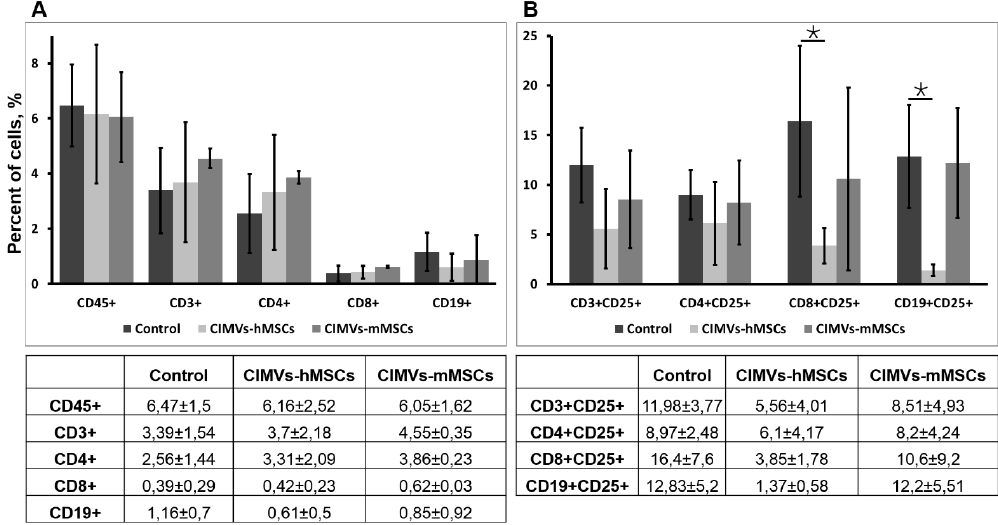
Figure 7. Immune response after CIMVs-hMSCs or CIMVs-mMSCs i.v. injection. Percent of the main populations of immune cells ( A ) and their activation status ( B ) were defined. Blood samples were collected 24 h after the i.v. injection with 15 µg of CIMVs-hMSCs or 15 µg of CIMVs-mMSCs. Percent of immune cells was determined using immunostaining and flow cytometry. The data represent mean ± SD.